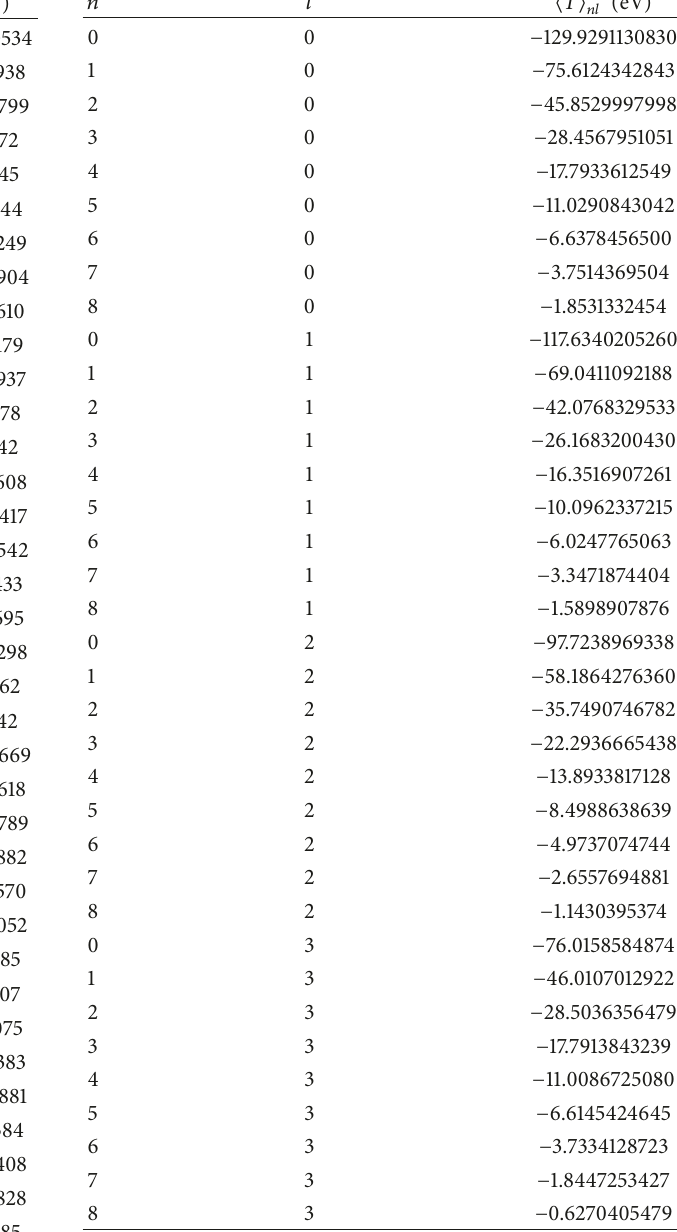
Table 12: Expectation values of ⟨𝑇⟩ for hydrogen chloride molecule. Table 13: Expectation values of ⟨𝑇⟩ for carbon ( 11 ) oxide